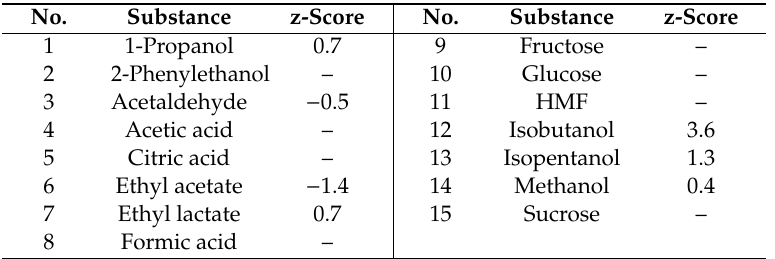
Table 7. z-scores of the 2018 proficiency test “sprits drink analysis”. No. Substance z-Score No.